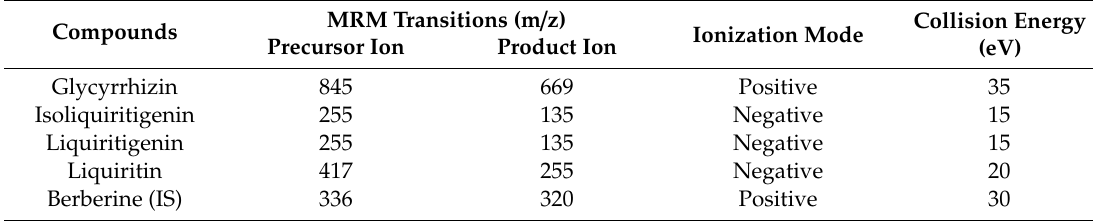
Figure 1. Structure and product ion mass spectra of ( A ) glycyrrhizin, ( B ) isoliquiritigenin, ( C ) liquiritigenin, and ( D ) liquiritin. Table 1. MS / MS parameters for the detection of the analytes and Table 1. MS/MS parameters for the detection of the analytes and IS.